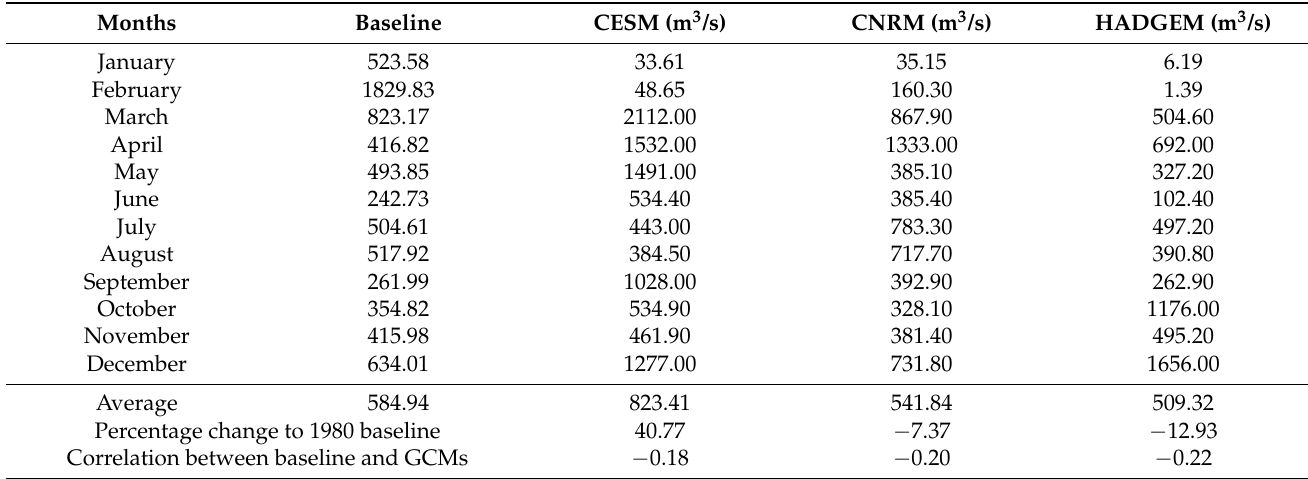
Figure 10. Simulated streamflow for1980 baseline and 2075 climate conditions. Table 6. Comparison of simulated 1980 baseline monthly streamflow (m 3 /s) to 2045 streamflow from the different General Circulation Models